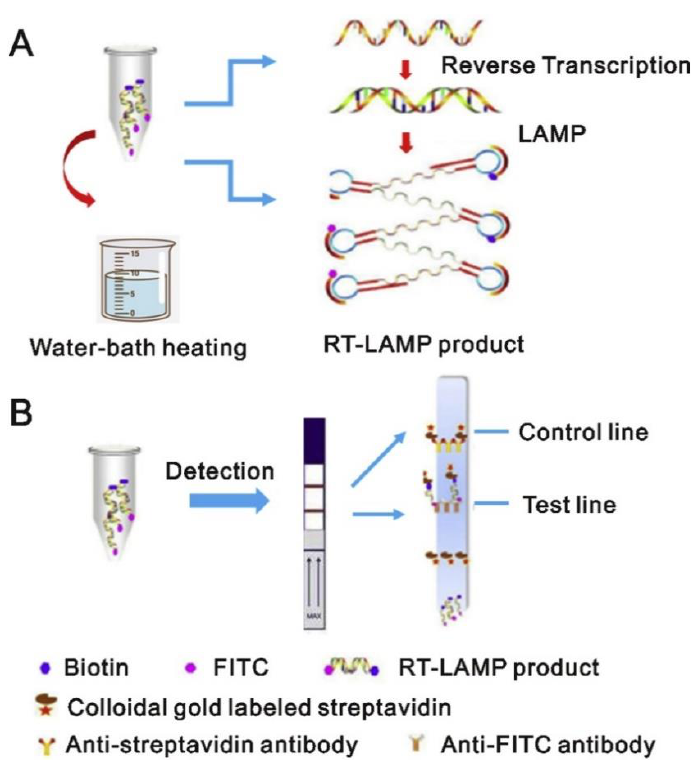
Figure 1. ( A ) Figure illustrates the working principle of RT-LAMP. RNA from the sample is extracted and converted to cDNA and then amplified using multiple cross-linked primers. Two loop primers, i.e., LF and LB, are labeled with fluorescein isothiocyanate and biotin, respectively. The amplicons, after replication, are labeled with biotin and FITC. A complex is made consisting of biotin-labeled amplicons with gold particles conjugated with streptavidin. While the anti-FITC antibody coated on the strip captures the complex conjugated with FITC. ( B ) The results can be observed visually on the test strip.